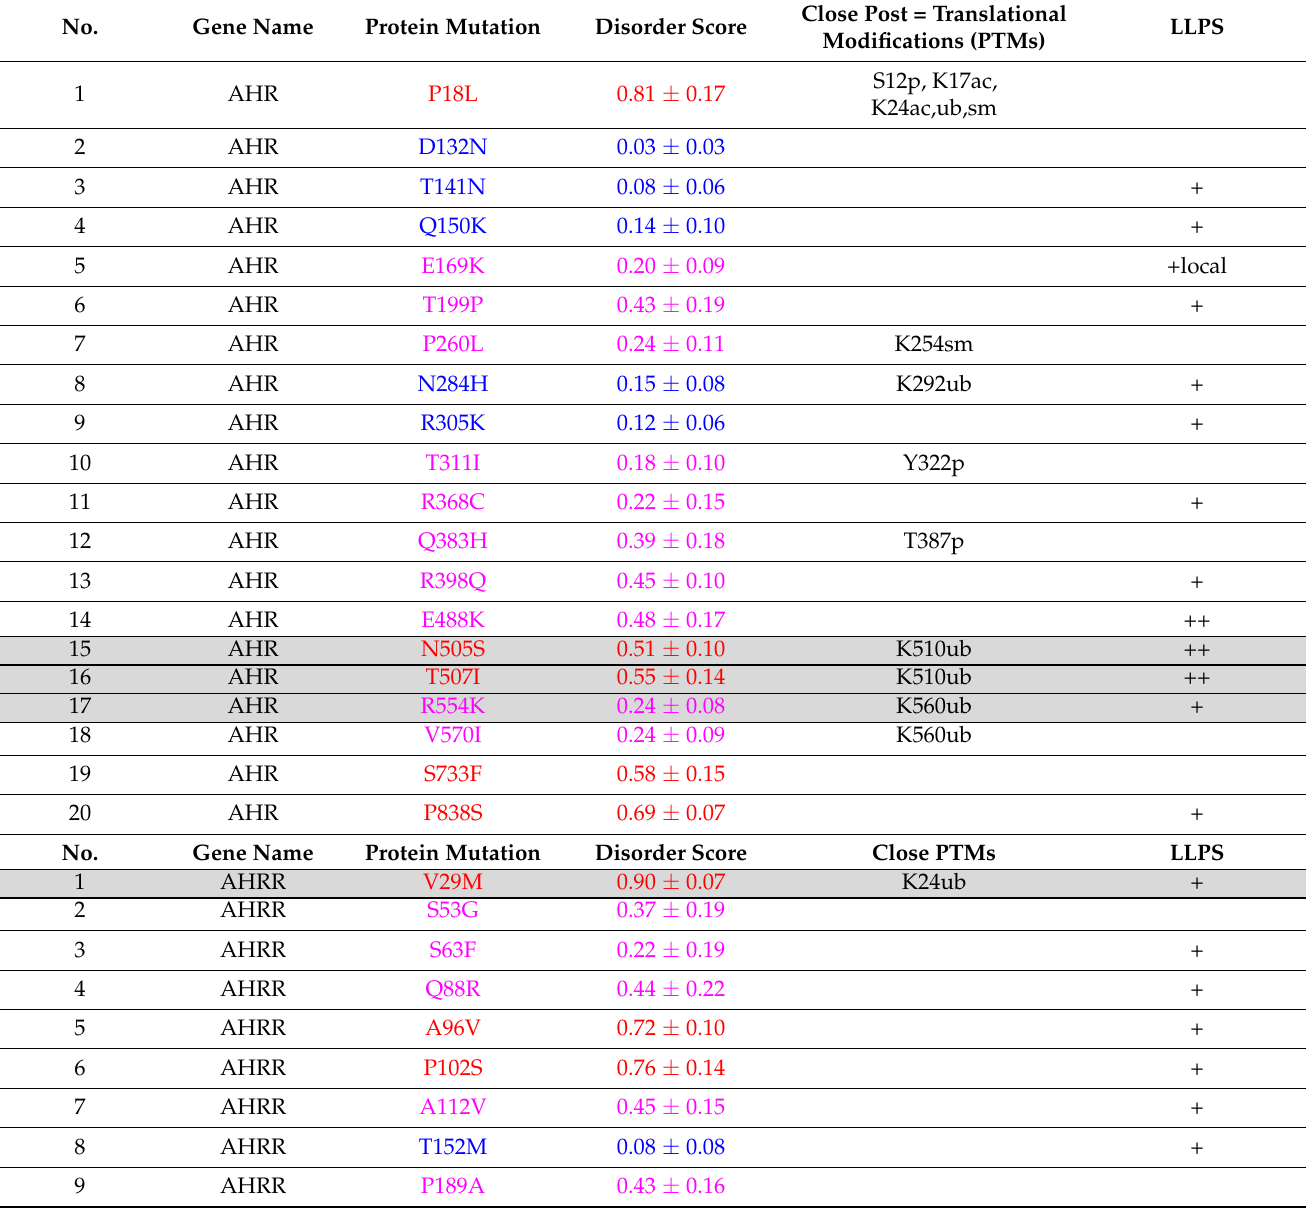
Table 1. Summary of AHR, AHRR, SIM1/2, Hif-2 α , NPAS4, ARNT2 and BMAL1 mutations, disorder scores, and PTM and LLPS analyses. Protein mutations (based on HuVarBase) are arranged in order. Disorder scores are determined by mean predicted intrinsic disorder score (PIDS mean ). Ordered regions (PIDS mean ≤ 0.15), flexible (i.e., with 0.15 < PIDS mean ≤ 0.5), and disordered (PIDS mean ≥ 0.5) regions are indicated by blue, pink, and red colors, respectively. Closely located documented PTMs (PhosphoSitePlus, distance < 12aa) are listed. PTM sites coinciding with mutation sites are highlighted in yellow. Abbreviations: ac—acetylation, m—methylation, p—phosphorylation, sm—sumoylation, ub—ubiquitylation. Predicted LLPS is marked with ‘+’, ‘+local’ for local maxima of predicted LLPS and ‘++’ for global maximum. Residues predicted as disordered, with close mutation sites and LLPS positive score are highlighted in